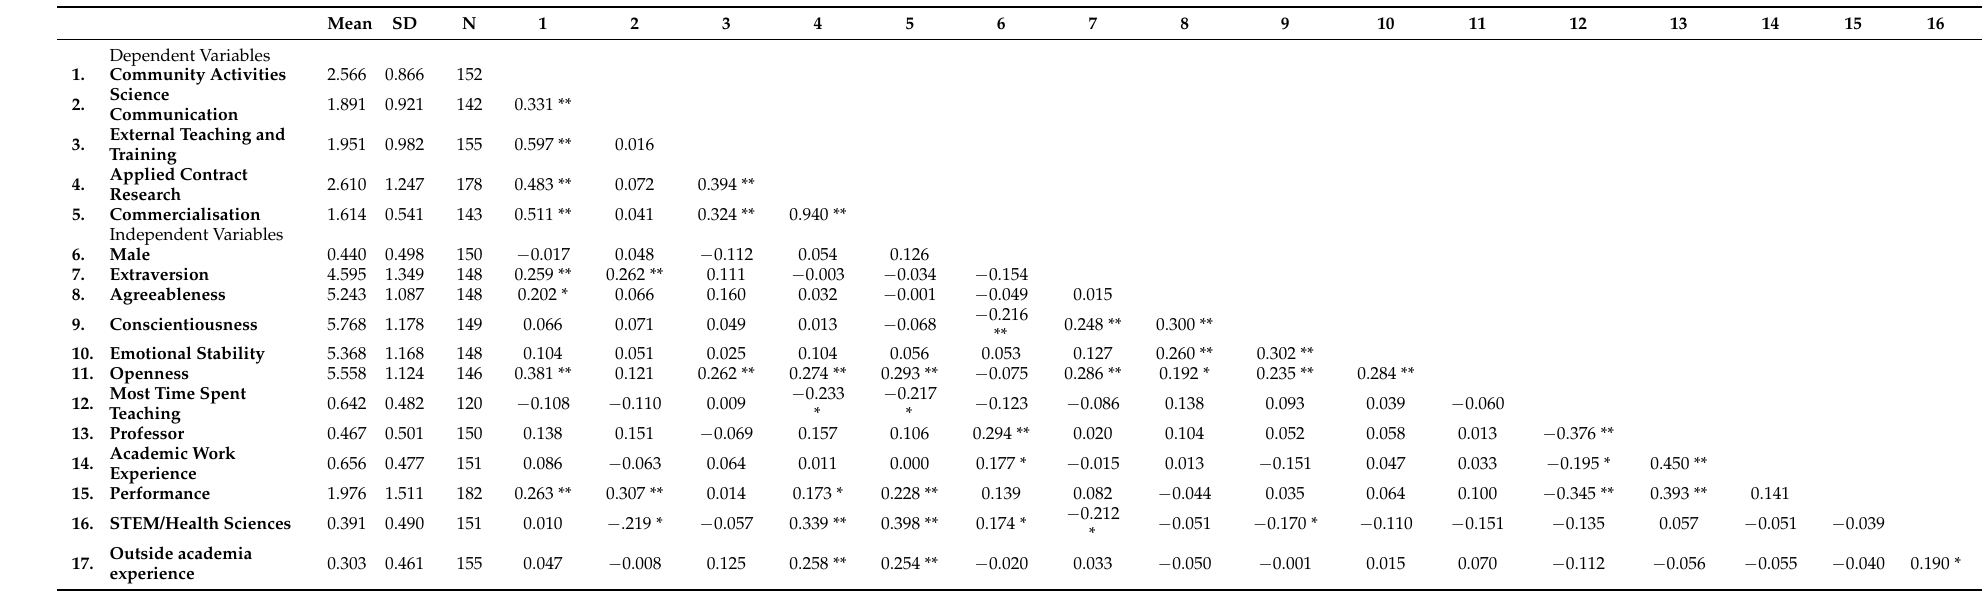
Table 4. Measures of central tendency and dispersion and Pearson’s r correlations for all variables in the